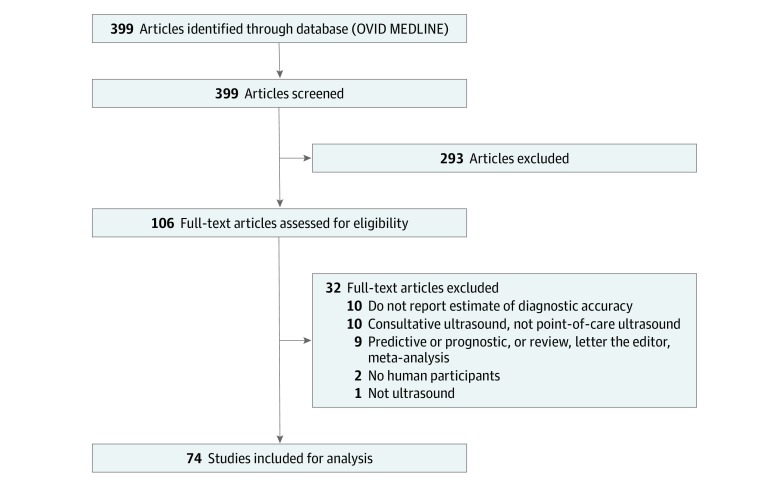
Study Flowchart